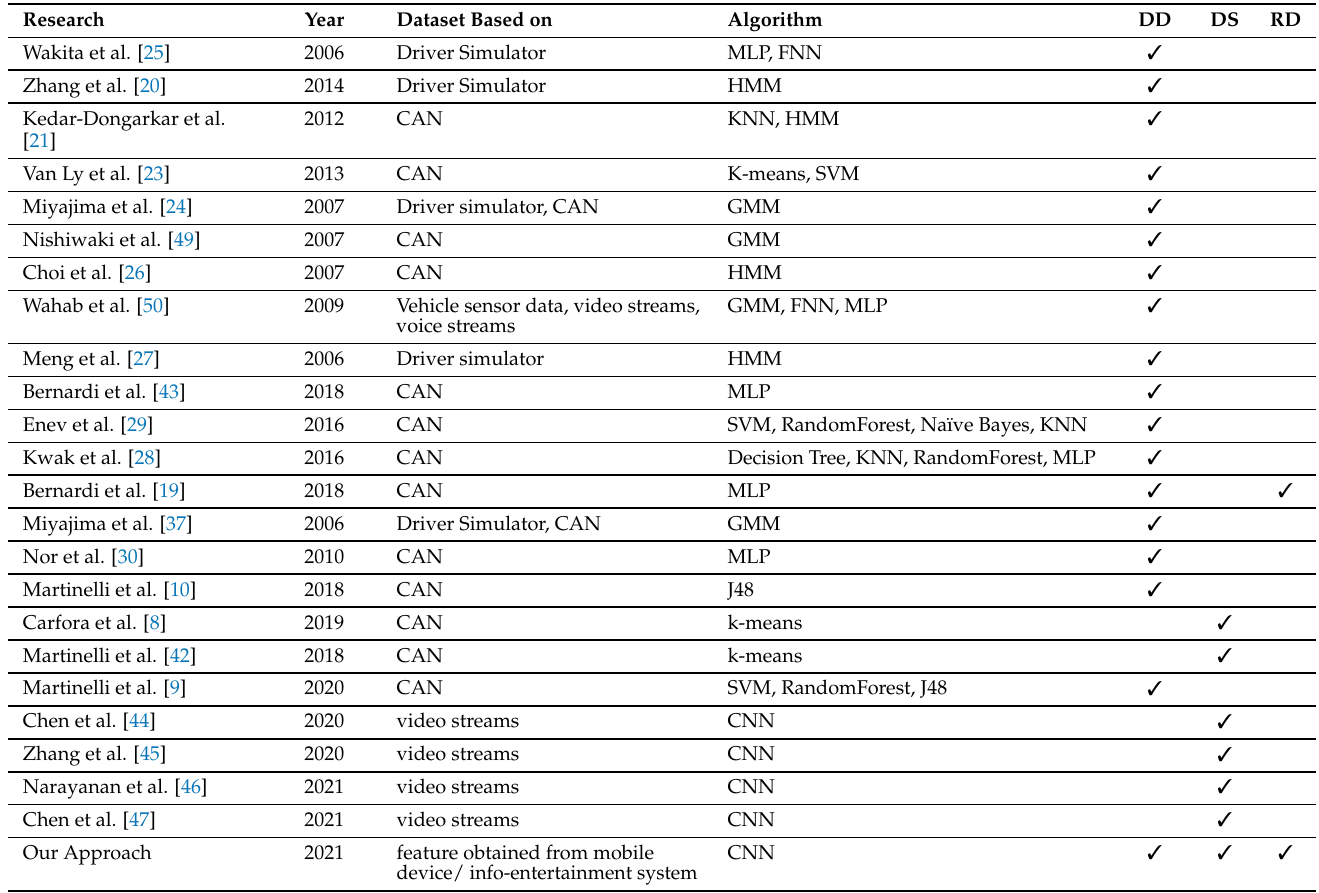
Table 4. Current Literature Comparison on Driver Behaviour Classification (column Research ) expressed in terms of: publication year (column Year ), dataset source (column Dataset ) real data extracted from the Controller Area Network (CAN) bus (i.e., CAN) or using a software simulator (i.e., Driver simulator) and other data obtained by software systems, the algorithms involved in the classification task (column Algorithm ) and the considered task (Driver Detection (column DD , Driving Style (column DS and Road Detection (column RD ).